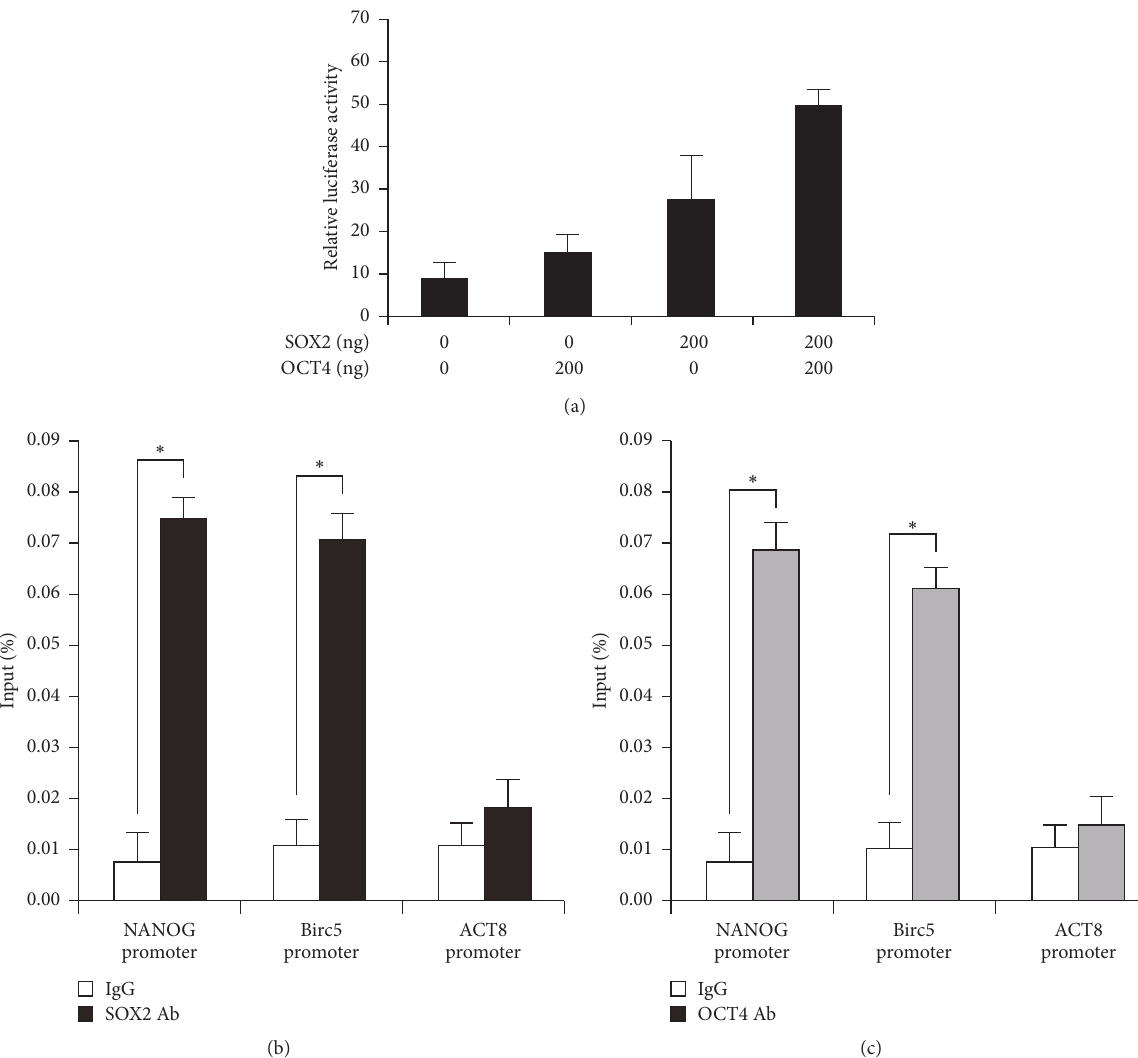
Figure 5: SOX2 and OCT4 synergistically regulate expression of Survivin in ES cells. ChIP-qPCRs were conducted using SOX2 and OCT4 antibodies and primers specific for promoter of NANOG, Survivin (Birc5), and the 𝛽 -actin genes. DNA lysates of cells were as input. NANOG was the positive control while 𝛽 -actin was the negative